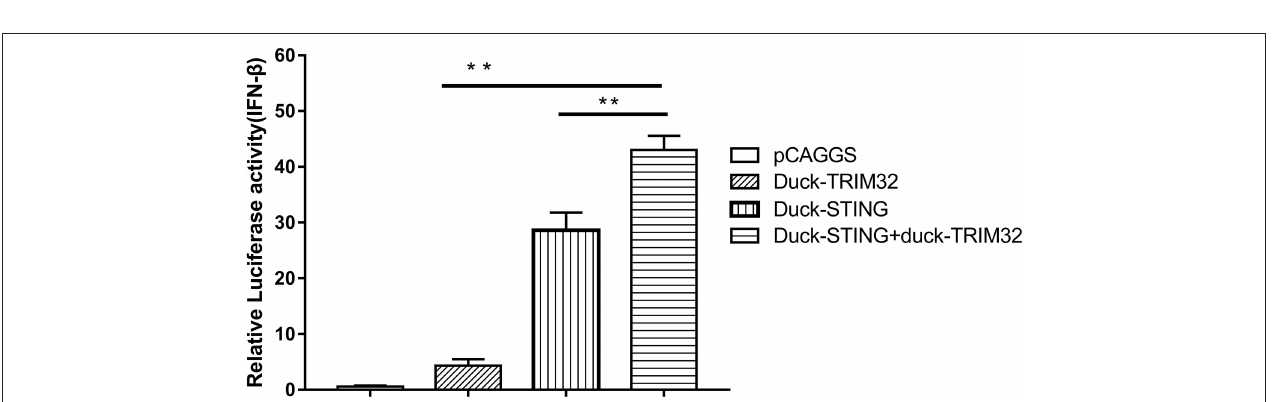
FIGURE 7 | DuTRIM32 contributes to duSTING-mediated expression of IFN- β . The DEFs (24 wells) were co-transfected with pGL3-IFN- β -Luc (0.1 µ g/well), PRL-TK plasmids (0.01 µ g/well), pCAGGS-duTRIM32-V5 (0.3 µ g/well), and/or pCAGGS-duSTING-HA (0.3 µ g/well). After 24h, DEFs were collected and tested for luciferase activities using the dual-luciferase Assay System. All data were expressed as means ± SD, the Student’s t -test was used to analyze the differences. (** p < 0.01).